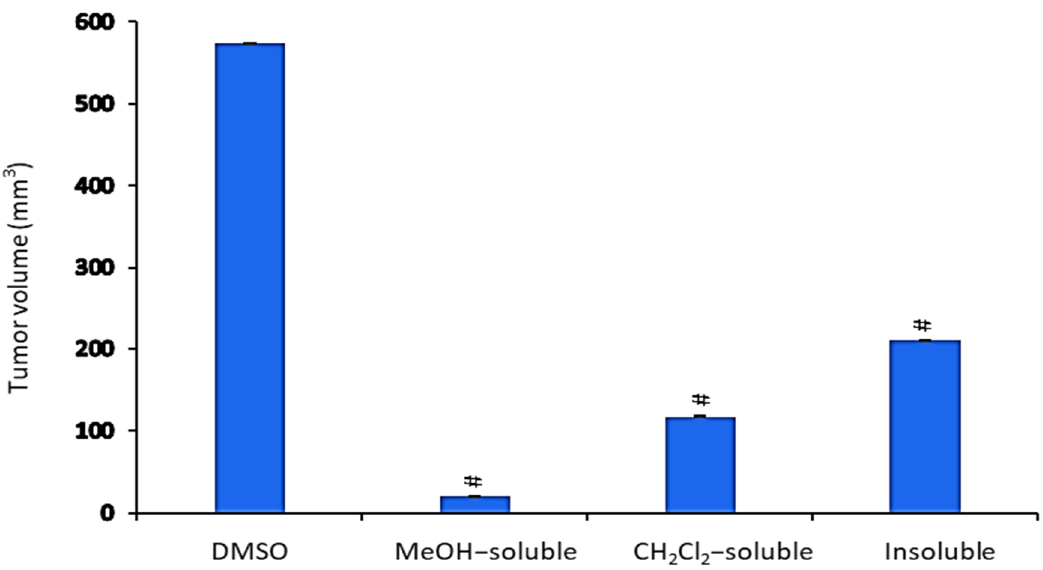
Figure 4. The effect of A. zerumbet extracts (MeOH, CH 2 Cl 2 , and insoluble) on tumor volume (TV). TV was calculated from the current equation: TV(mm 3 ) = 0.52 × longest diameter × (shorter diameter) 2 . Data was expressed as mean ± SEM. Significantly ( # p < 0.001) different from the vehicle control (tumor + DMSO).